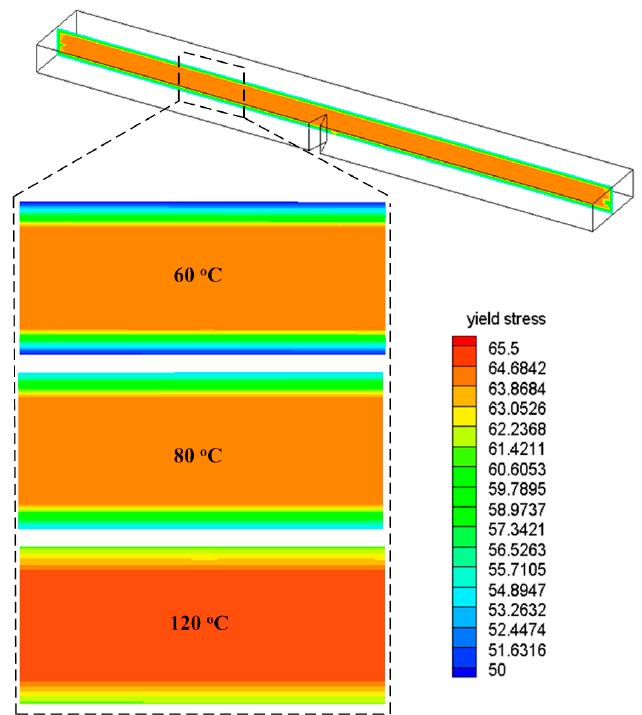
Figure 6. Yield stress distributions of the specimens with different mold temperatures.